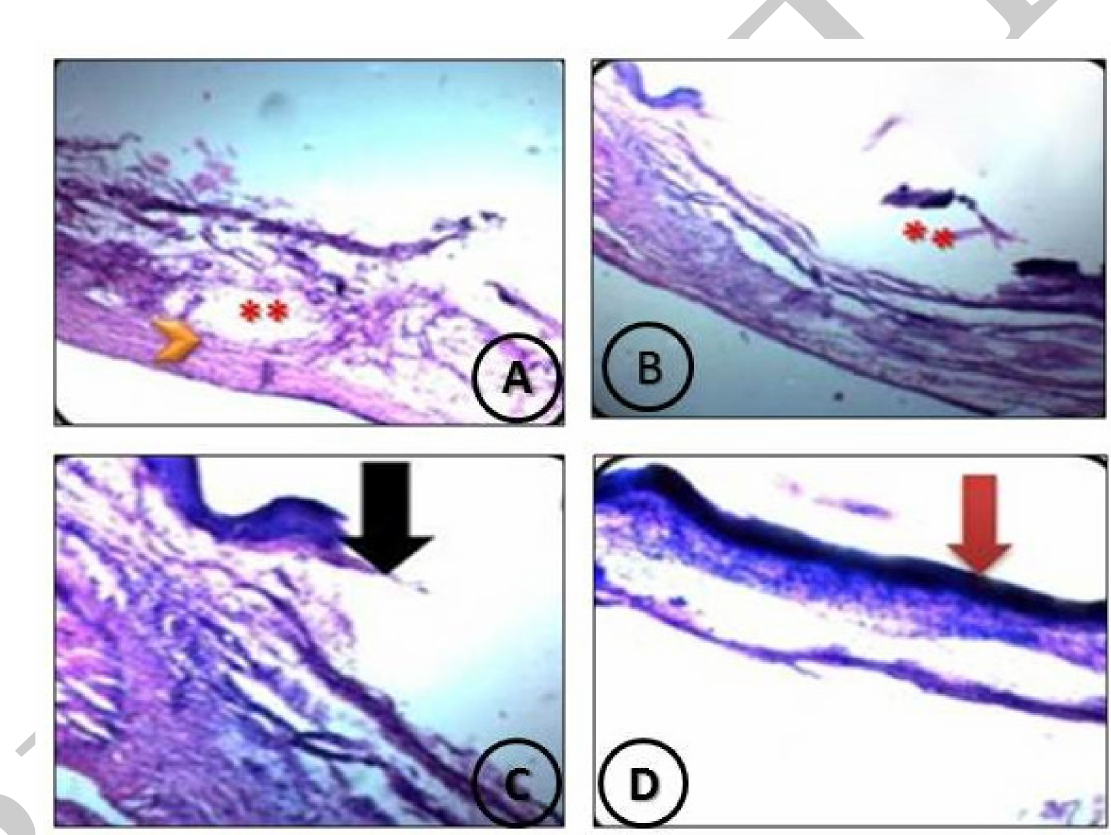
Figure 13. Histological sections of the diabetic untreated group and the diabetic group treated with the C. molle extract. ( A ) Control diabetic deep wound non-treated group with epidermal ulceration (**) with infiltration of the dermis by dense aggregates of esinophils (orange head arrow). ( B – D ) Treated diabetic deep wound group showing improvement in the dermal layers, which is represented by the partial restoration of the epidermis layer and the formation of its keratinized layers in first and third (**) and black arrow, respectively) weeks of treatment, with almost complete restoration of the epidermal layer after the fourth week of treatment (red arrow) (H &